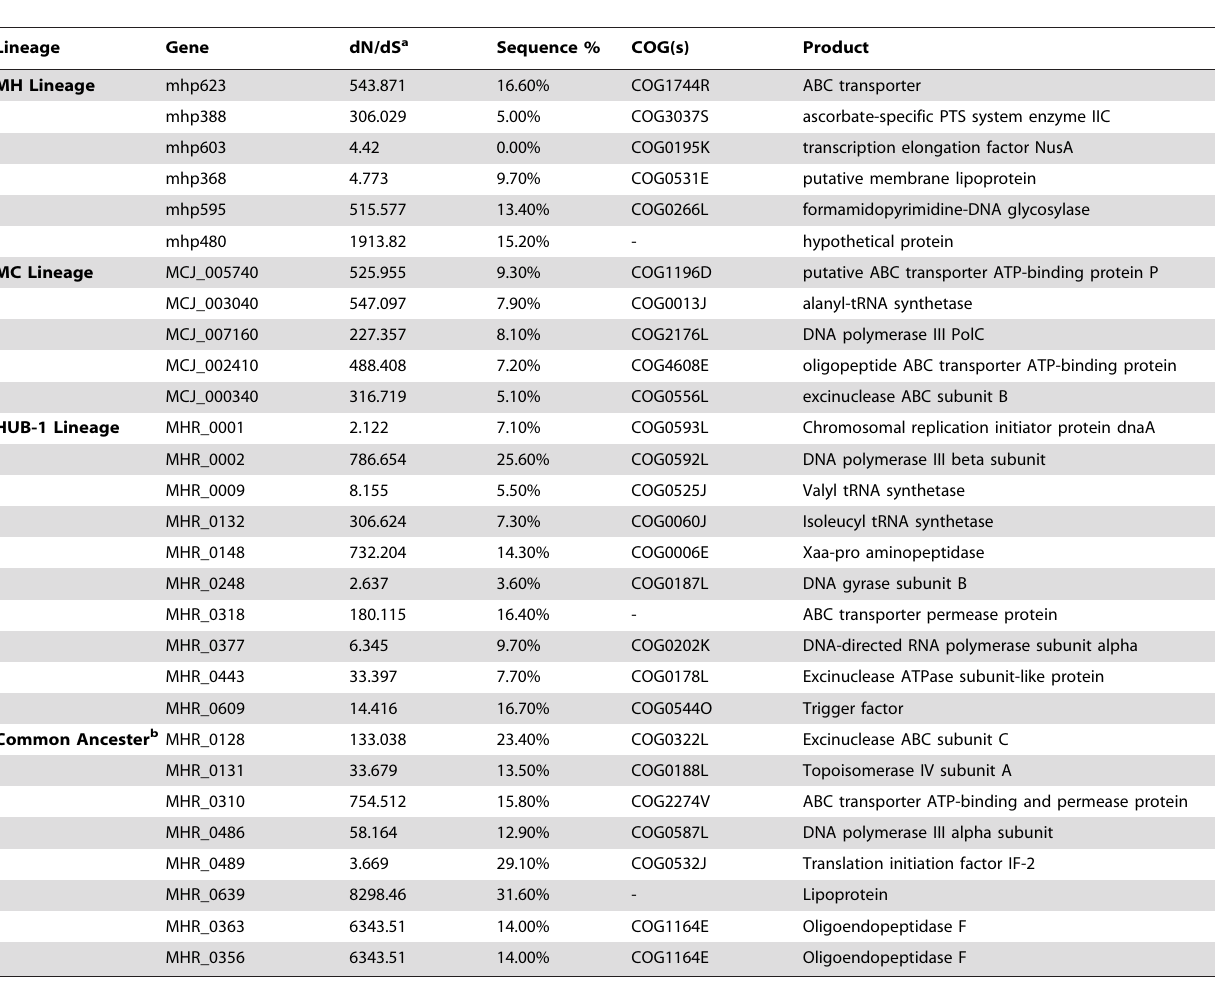
Table 2. Genes under Positive Selection in Swine-infecting Lineages.